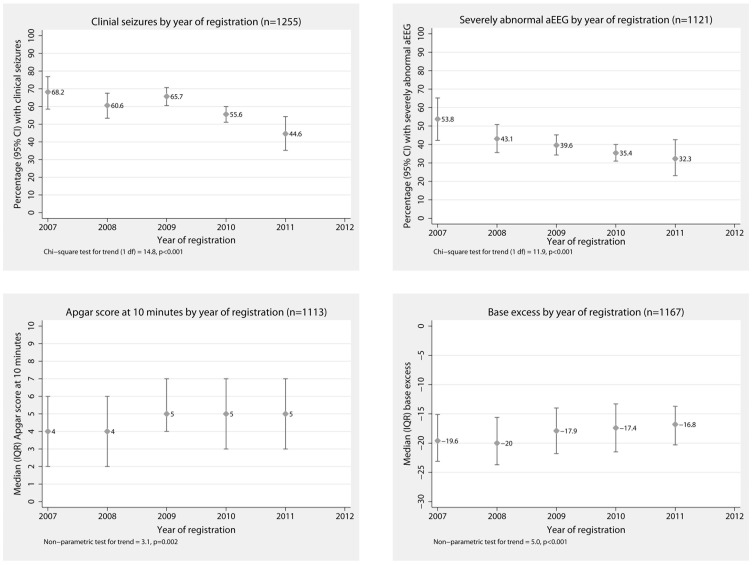
Clinical characteristics by year of registration.